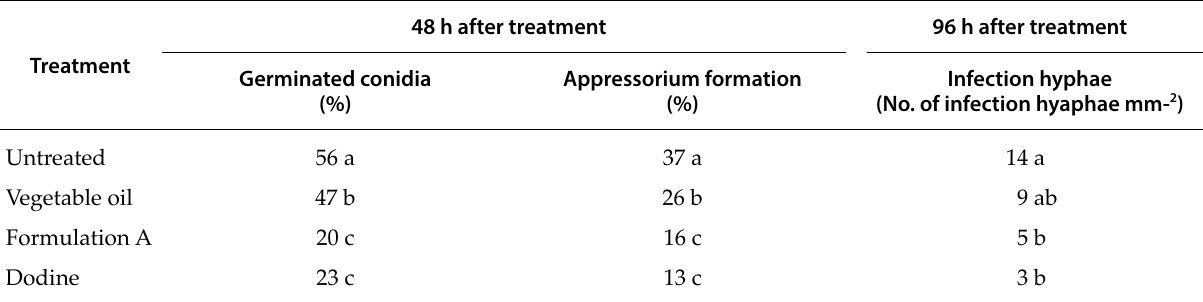
Table 1. Mean proportions of germinated conidia and appressorium formation for F. oleagineum 48 h after different treat - ments had been applied, and mean number of infection hyphae on 1 mm 2 of leaf 96 h after treatment. The data were arcsine-transformed before the analysis. Values with different letters are statistically different ( P <0.05) as determined by Fisher’s protected least significant difference